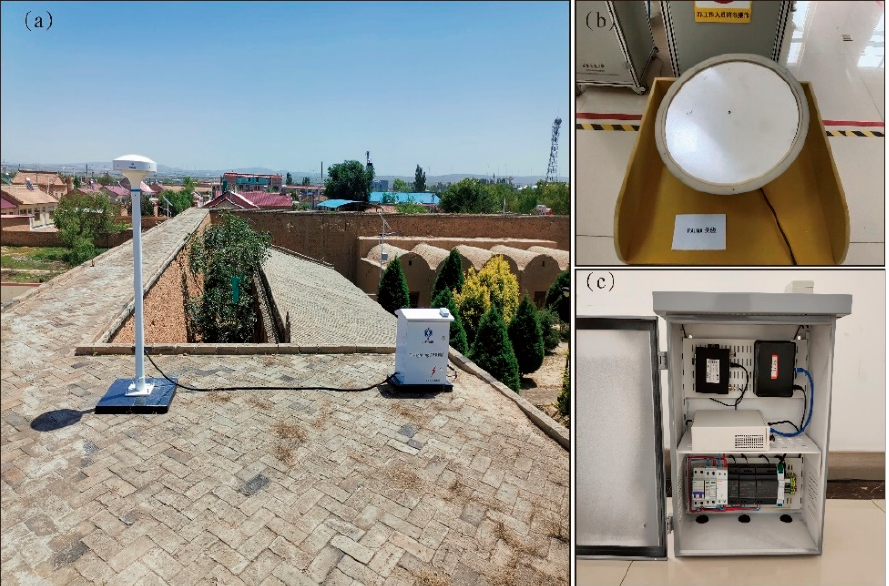
Figure 2. The field scene at site TJZ ( a ); that is equipped with a fast antenna ( b ); and controlling box ( c ).